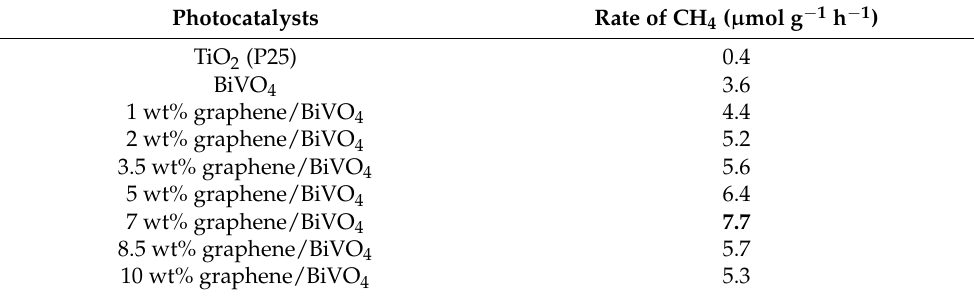
Table 3. Production rate of CH 4 on various loading of graphene with BiVO 4 .